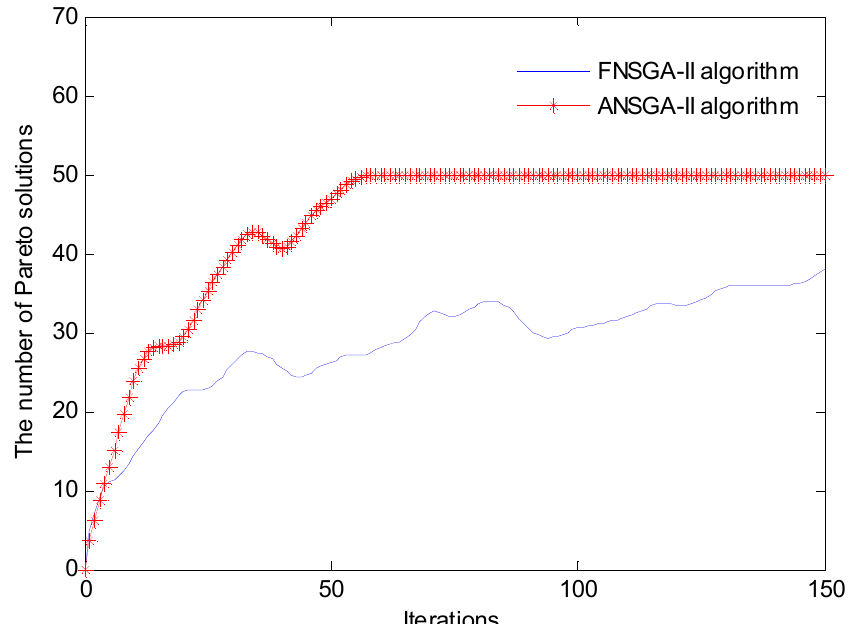
Figure 8. The variation trend of non-dominated individuals.